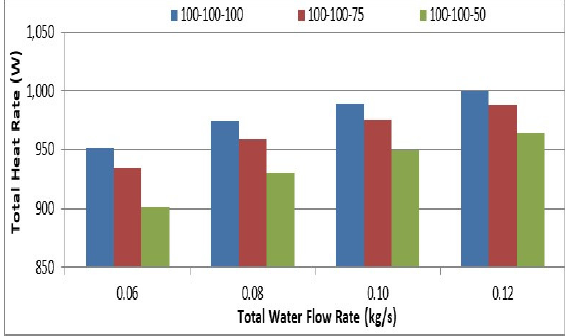
Fig. 10. The total heat rate of terminal units at 8°C water supply temperature and valve opening: Valve 1=100%, Valve 2=100 % and Valve 3=100-75-50%.